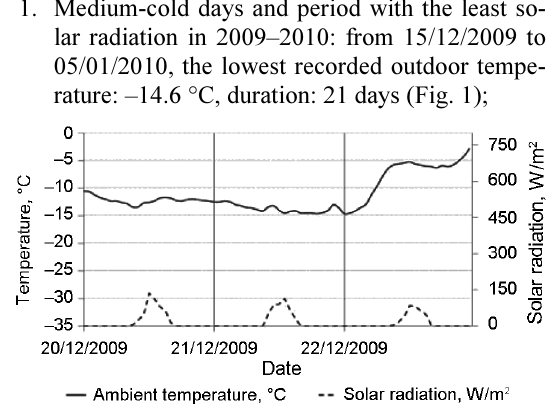
Table 1 . Geometrical properties of the building used for modeling of dynamics of indoor temperature Areas of construction surfaces of the building, m